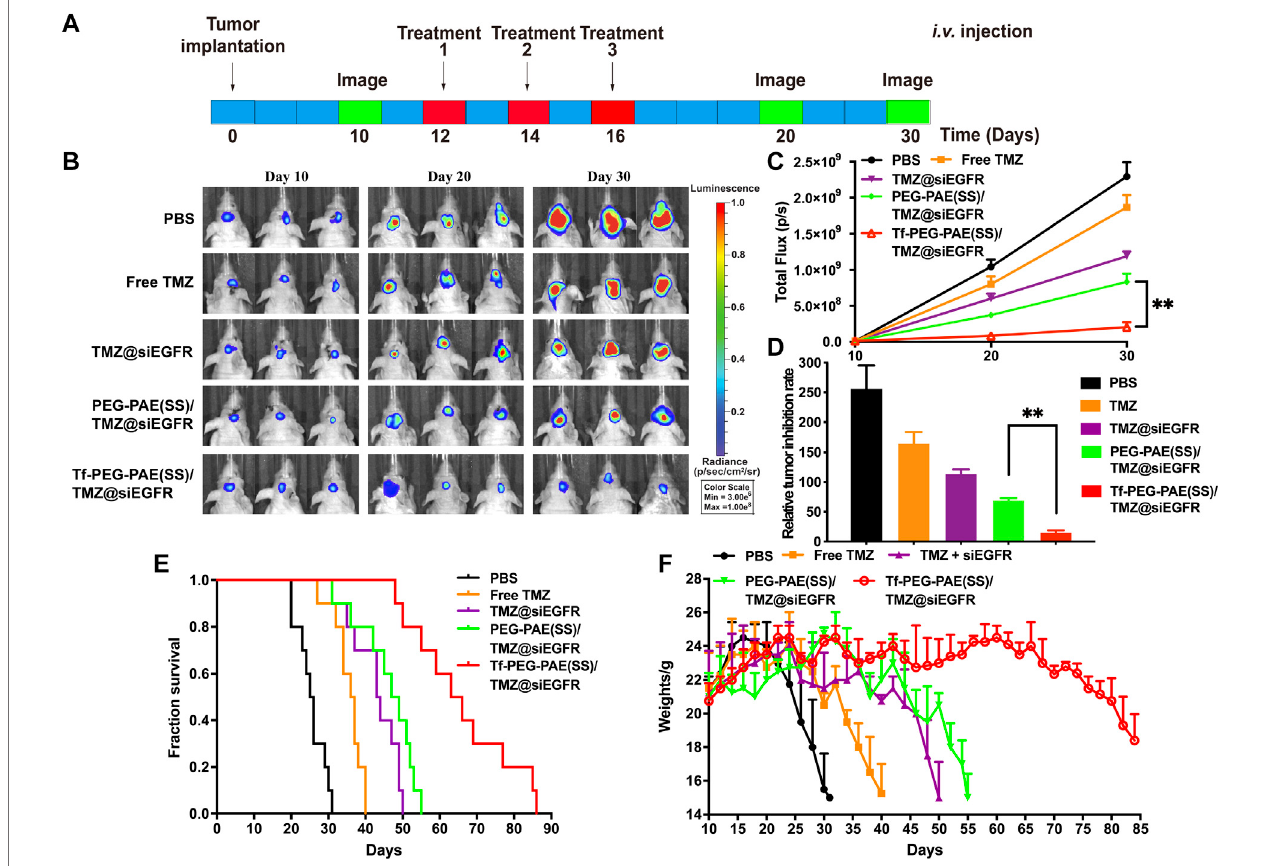
FIGURE 10 | Synergistic anticancer activity of complex nanoparticles on the U87-Luci glioma mouse model. (A) U87-Luci-bearing mice received fi ve injections of PBS, free TMZ, TMZ@siEGFR, PEG-PAE(SS)/TMZ@siEGFR, and Tf-PEG-PAE(SS)/TMZ@siEGFR. (B) Bioluminescence signal change of different groups. (C) Quanti fi cation of the tumor bioluminescence signal (n = 10), pp p < 0.01. (D) Relative tumor inhibitory rate for each group, pp p < 0.01. (E) Kaplan – Meier survival curves for the mice (n = 10). (F) Body weights changed (n =